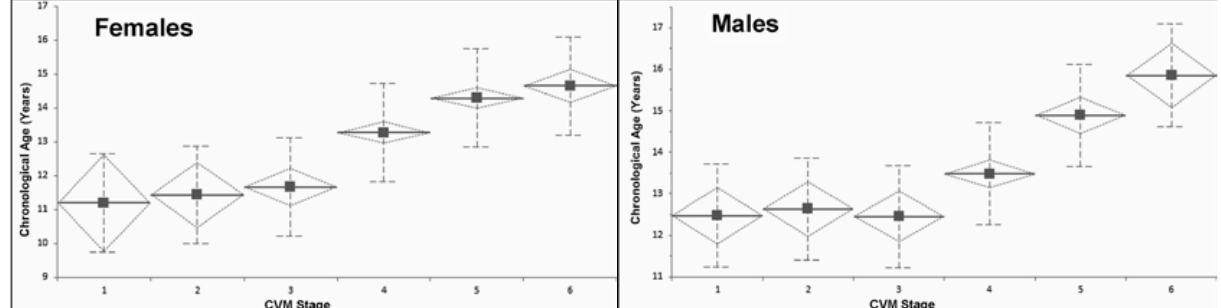
Figure 1. Mann Whitney U-test used to plot CA vs CVM stages for both females and males. There was no significant difference between consecutive stages. Height of dotted triangles – 95% CI, Dashed lines = 1 SD.